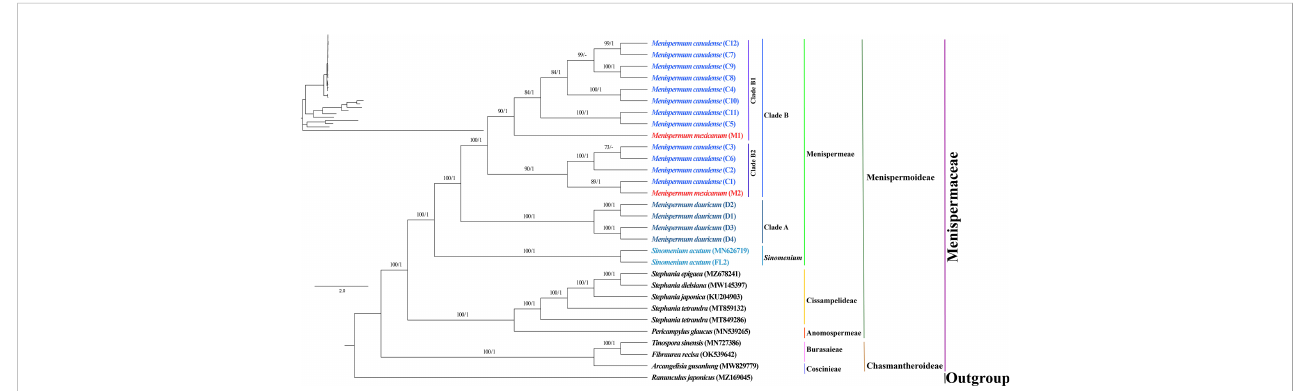
FIGURE 3 Maximum likelihood (ML) and Bayesian inference (BI) phylogeny based on 29 complete plastomes of Menispermaceae, with Ranunculus as outgroup. Numbers at each node represent ML bootstrap support (BS) and BI posterior probability (PP) values, respectively. Hyphens indicate the nodes not found in the strict consensus BI tree. The phylogram on the upper left shows the relative branch lengths. Sample codes are the same as in Table